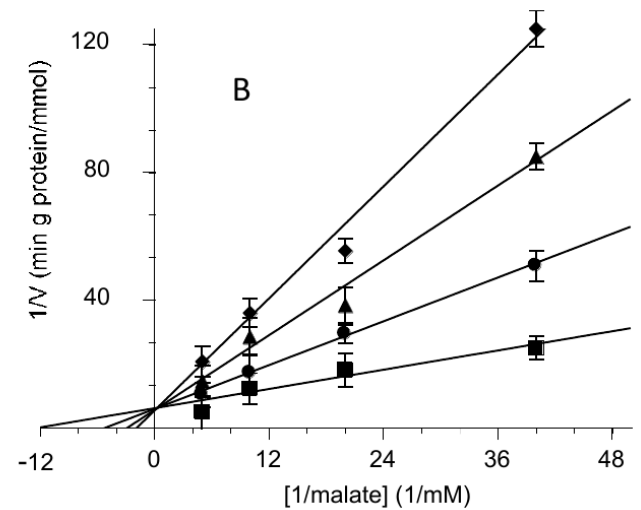
Figure 3. Competitive inhibition of the 2-oxoglutarate or malate transport activity by hemin. Double reciprocal plot showing the dependence of the uptake rate on hemin external concentrations. The transport rate of [ 14 C] 2-oxoglutarate ( A ) or [ 14 C] malate ( B ) in proteoliposomes containing 6 mM of 2-oxoglutarate was measured in 2 min in the absence ( (cid:4) ) or presence of hemin at 0.5 µ M ( • ), 2 µ M ( (cid:78) ) and 3.5 µ M ( (cid:7) ). Hemin was added together with [ 14 C] 2-oxoglutarate ( A ) or [ 14 C] malate ( B ) at concentrations of 0.025 mM, 0.05 mM, 0.1 mM and 0.2 mM. The data are the means ± SD from three different experiments.